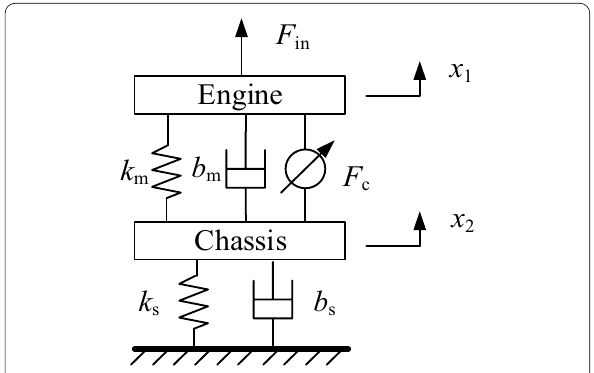
Figure 1 Two-degree-of-freedom active mounting system